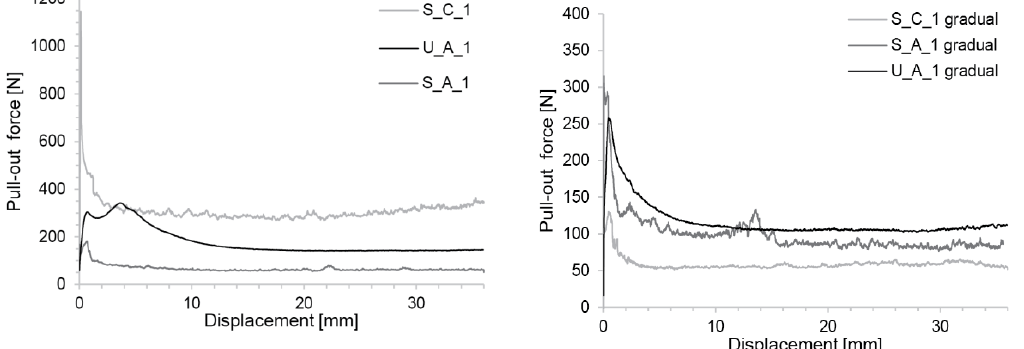
Figure 10. Pull-out stress of the different compositions recorded in friction tests. (Left) Concrete is cast in one go. (Right) Gradual filling mimicking SDC process.